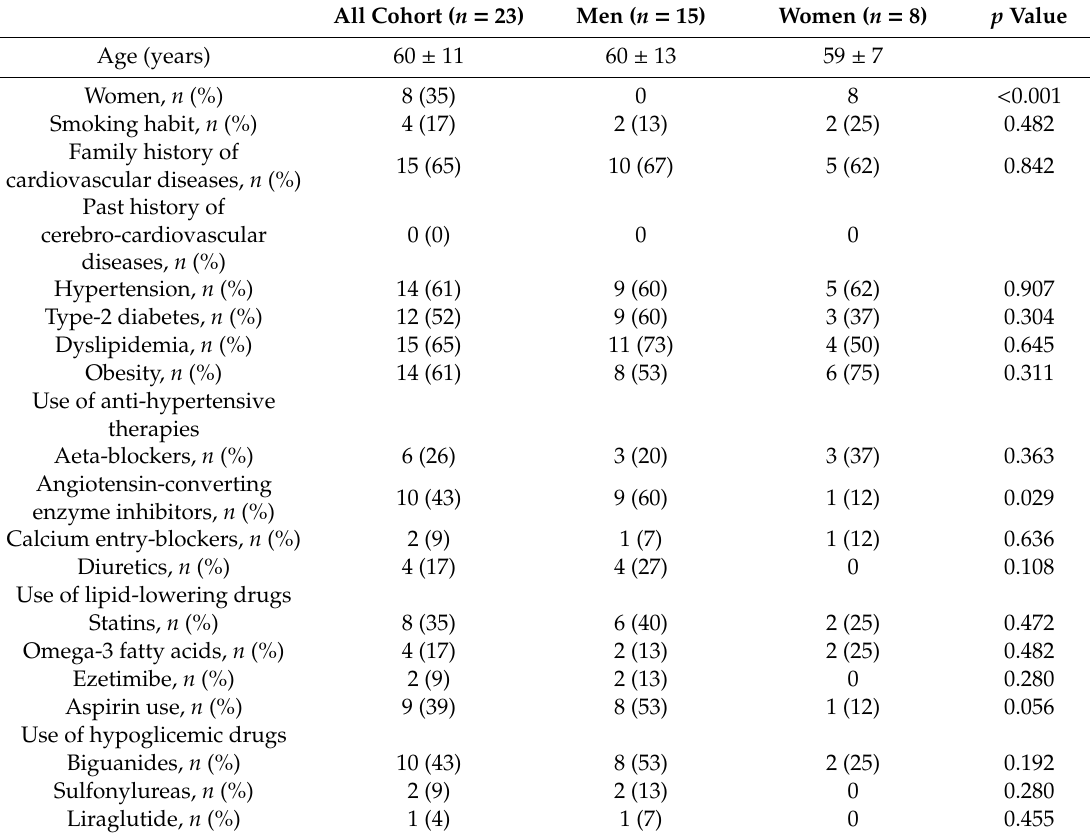
Table 4. Baseline characteristics of all